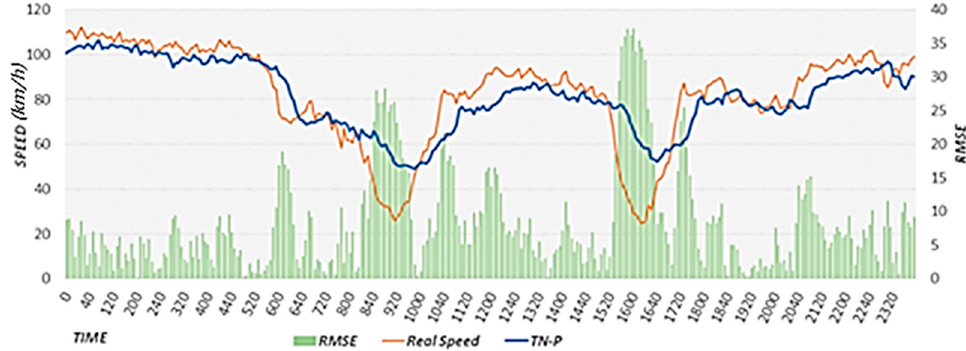
Figure 20. Results of predicting the road speed using the TN-P scheme.